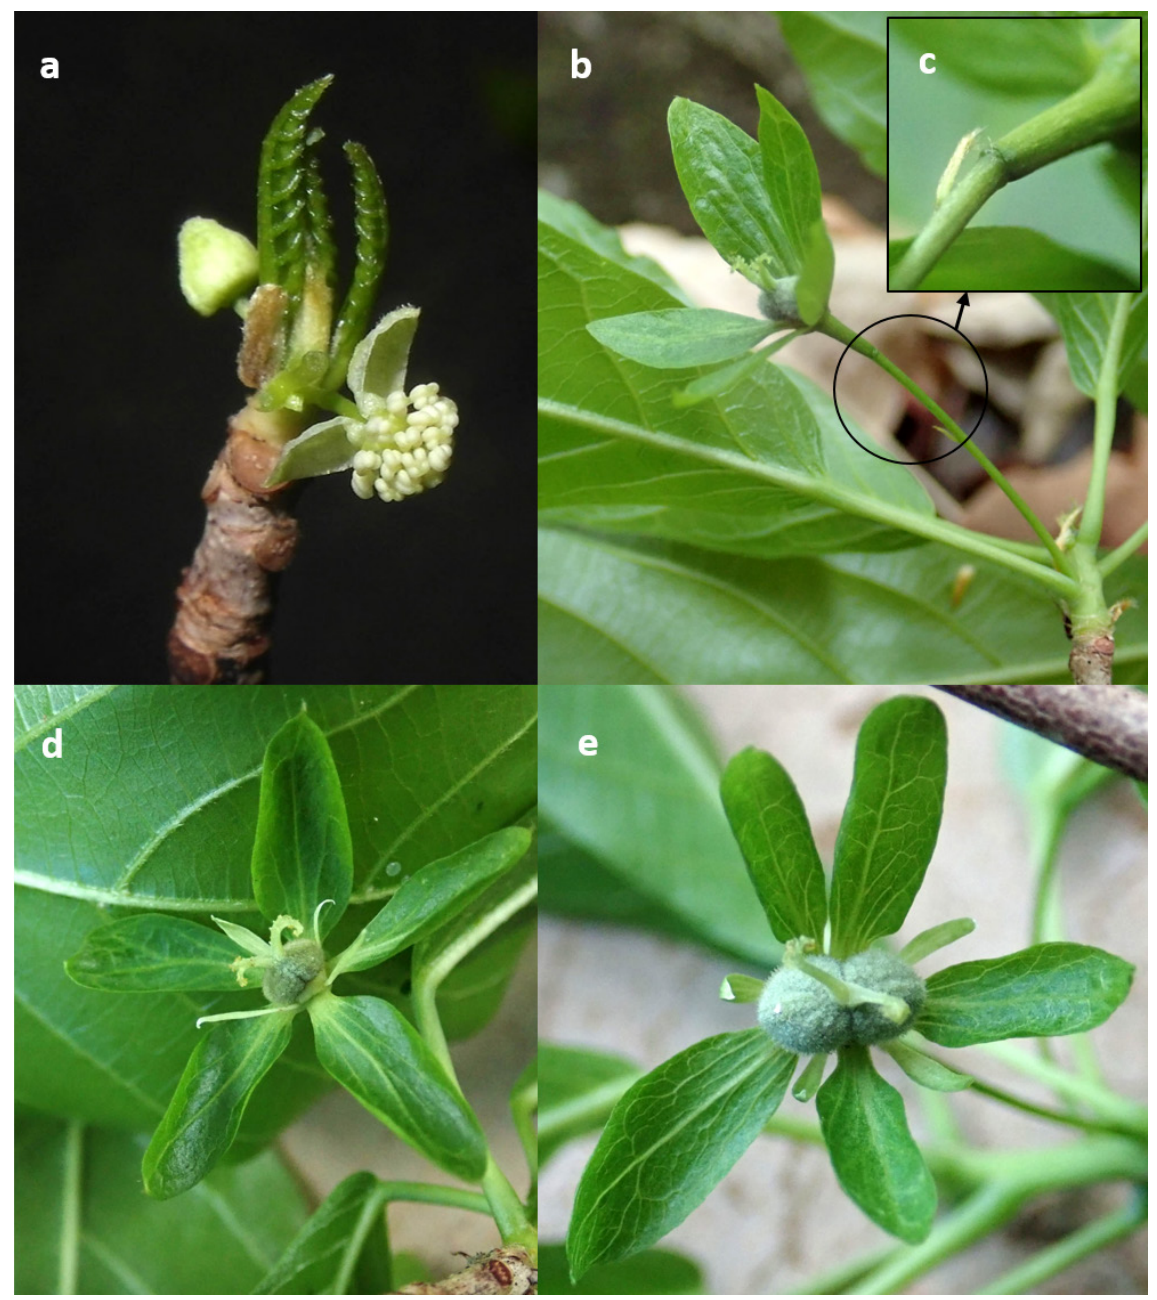
Fig. 6. Field photographs of Paranecepsia andrafiabensis Barberá & O.Lachenaud sp. nov. a . Staminate inflorescence. b . Pistillate inflorescence. c . Detail of the bract of the pistillate flower. d . Pistillate flower, lateral view. e . Pistillate flower, top view. From Barberá et al. 2799 (a), Barberá et al. 2765 (b–c), Barberá et al. 2771 (d), Barberá et al. 2772 (e). Photos by P. Antilahimena (a) and P. Barberá